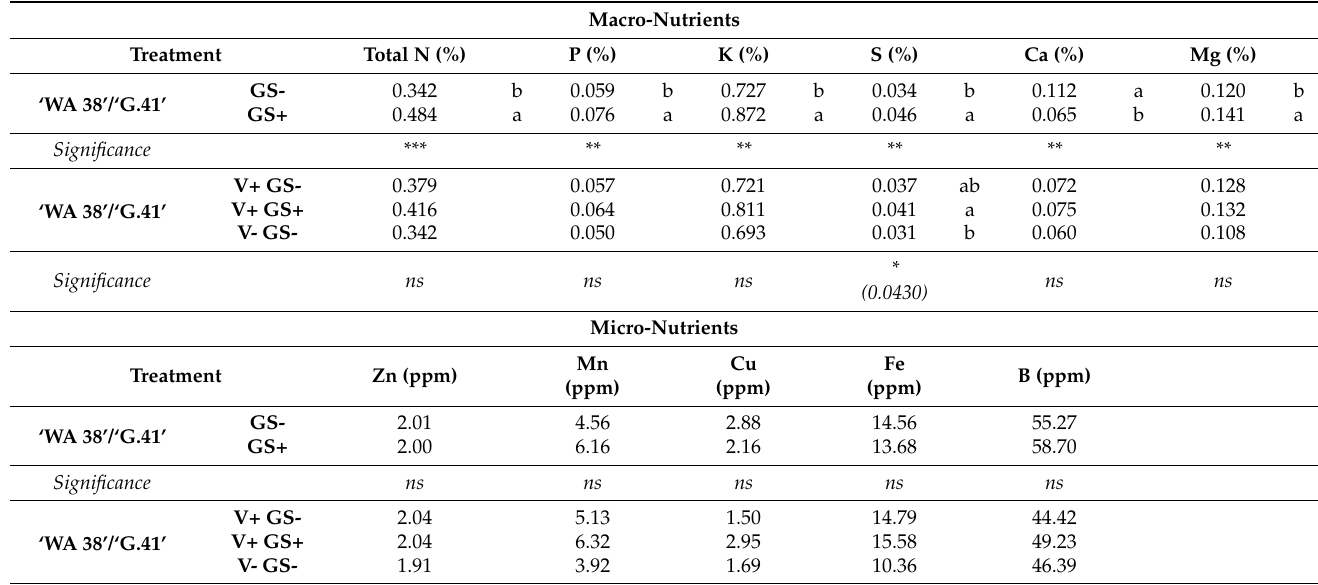
Table 5. ‘WA 38’/‘G.41’ peel mineral composition in 2020: comparison between symptomatic (GS+) and asymptomatic (GS-) apples, and comparison between combinations of high vigor with (V+